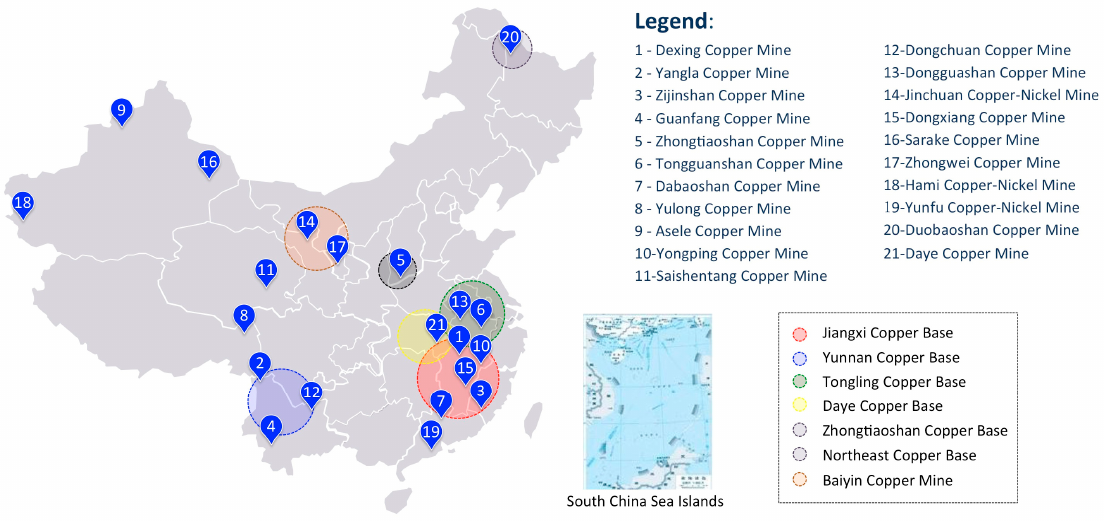
Figure 2. Regional distribution of typical bioleaching industrial plants in China.